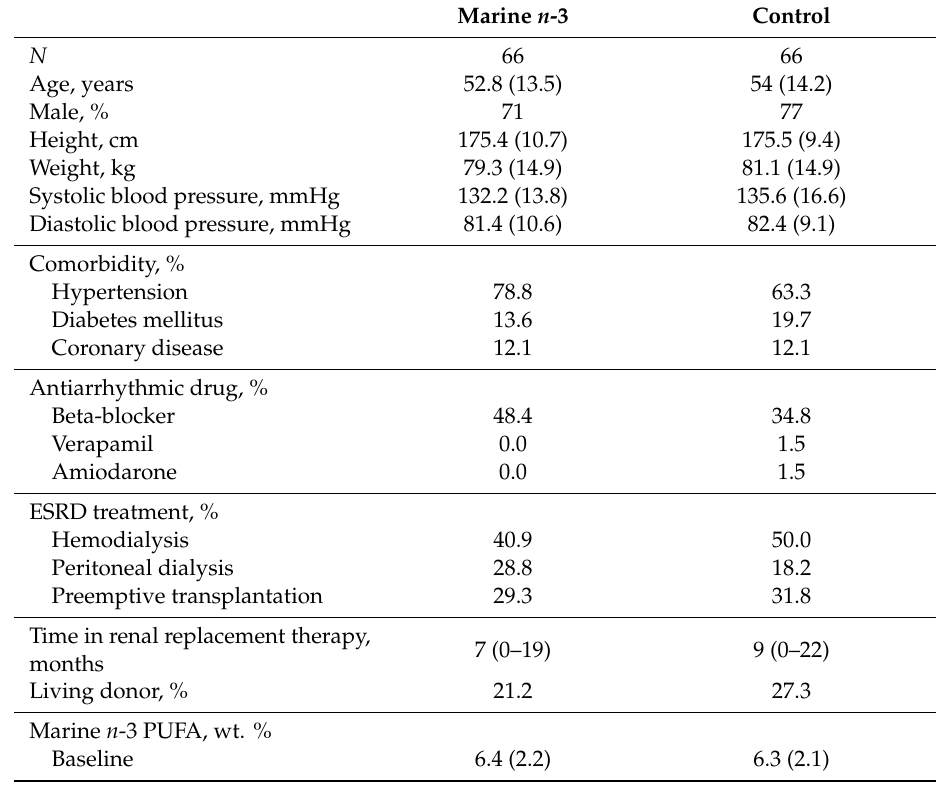
Table 1. Baseline